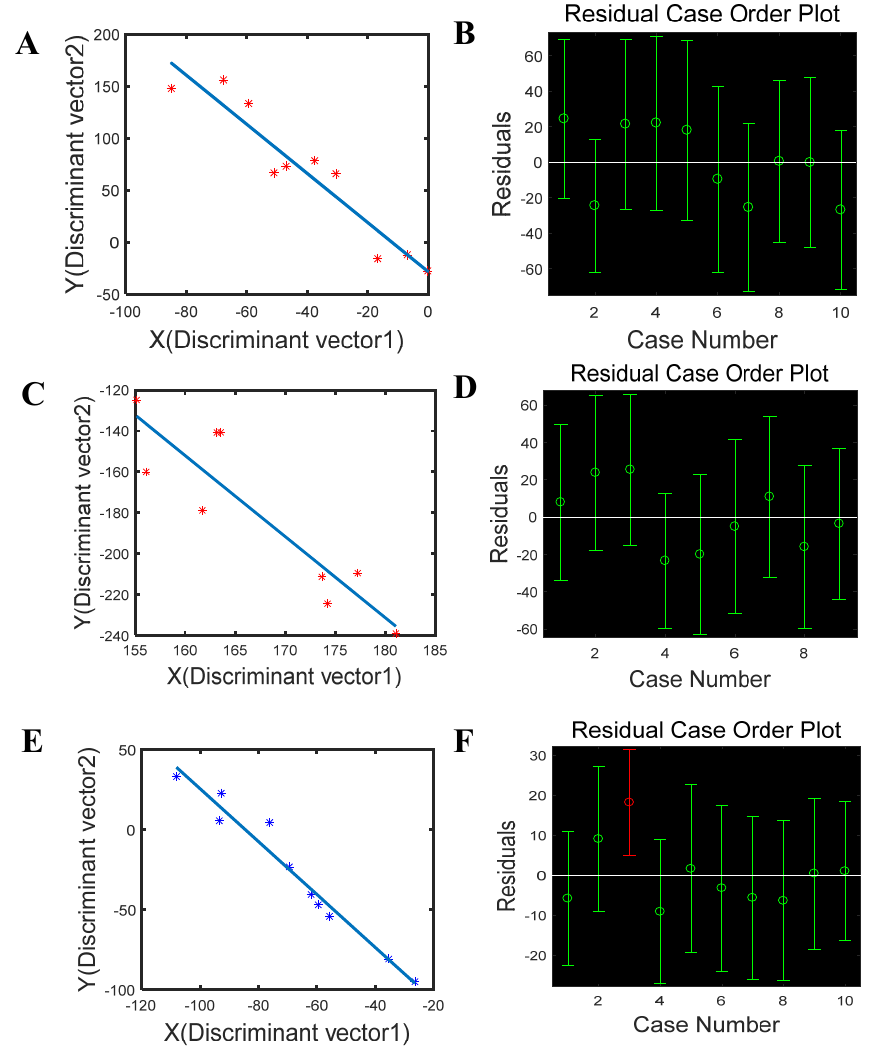
Figure 3. The univariate linear fitting results of ( A ) avermectin and ( B ) its tested residuals results, ( C ) phorate and ( D ) its tested residuals results, as well as ( E ) imidacloprid and ( F ) its tested residuals results.